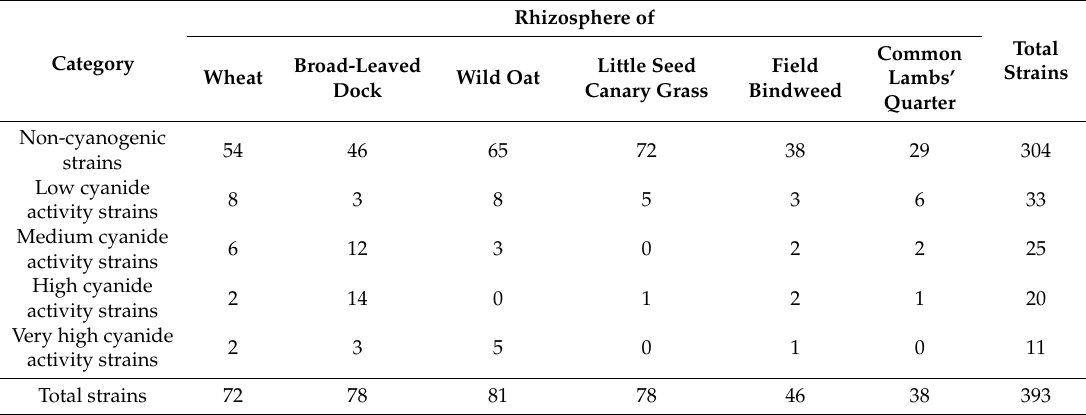
Table 1. The proportion of cyanogenic rhizobacteria in the rhizosphere of wheat and its associated weeds. The cyanide production by the strains was indicated after 48, 36, 24, and 12 h of incubation for low, medium, high, and very high cyanide production activity, respectively. Rhizosphere of Total Common Category Little Seed Field StrainsWheat Broad-Leaved Wild Oat Lambs’ Dock Canary Grass Bindweed